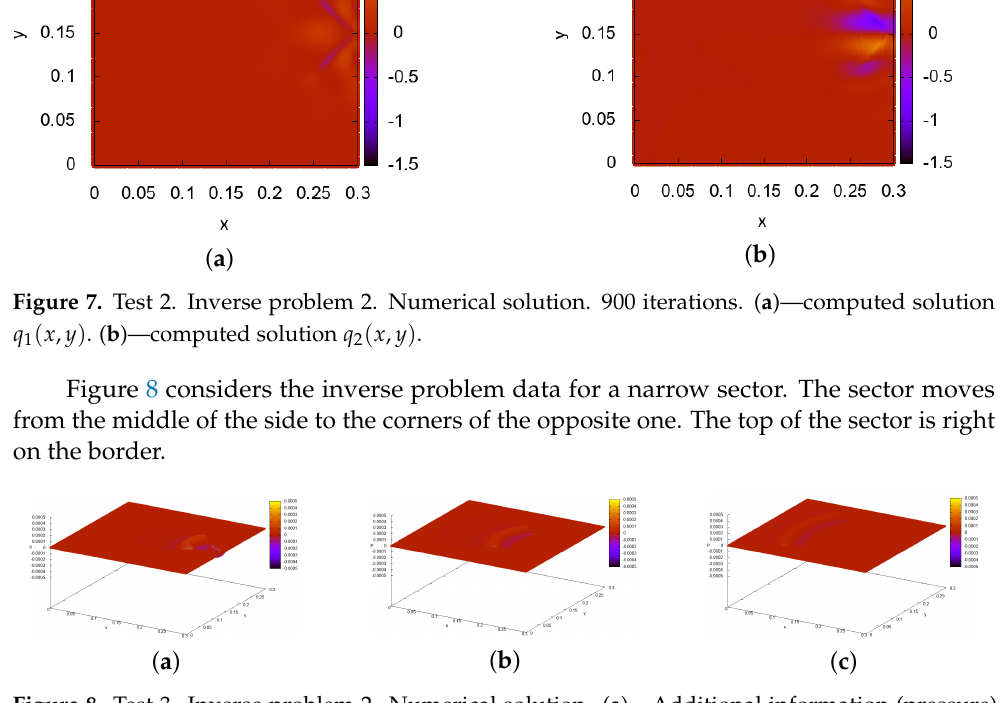
Figure 8. Test 3. Inverse problem 2. Numerical solution. ( a )—Additional information (pressure) p ( x , y ,0.06 ms ) . ( b )—additional information (pressure) p ( x , y ,0.11 ms ) . ( c )—additional information (pressure) p ( x , y ,0.16 ms )